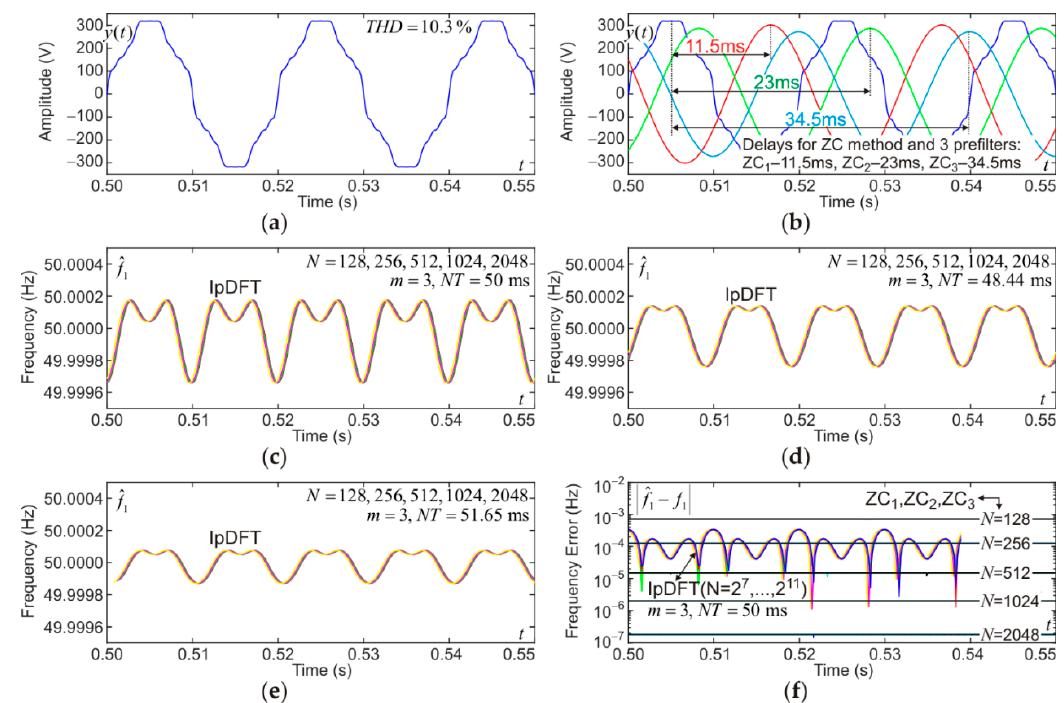
Figure 14. Effect of harmonics on estimation results: ( a ) 50 Hz power network signal model of THDS U = 10.3%; ( b ) delays brought on by 6th-order (ZC 1 ), 12th-order (ZC 2 ) and 18th-order (ZC 3 ) filters for ZC; ( c – e ) frequency estimation by IpDFT for m = 3 and of N samples at measurement times of 50 ms, 48.44 ms and 51.65 ms; ( f ) comparison of the accuracy of the IpDFT method for m = 3 and NT = 50 ms with the ZC method for N = 128, 256, 512, 1024 and 2048.